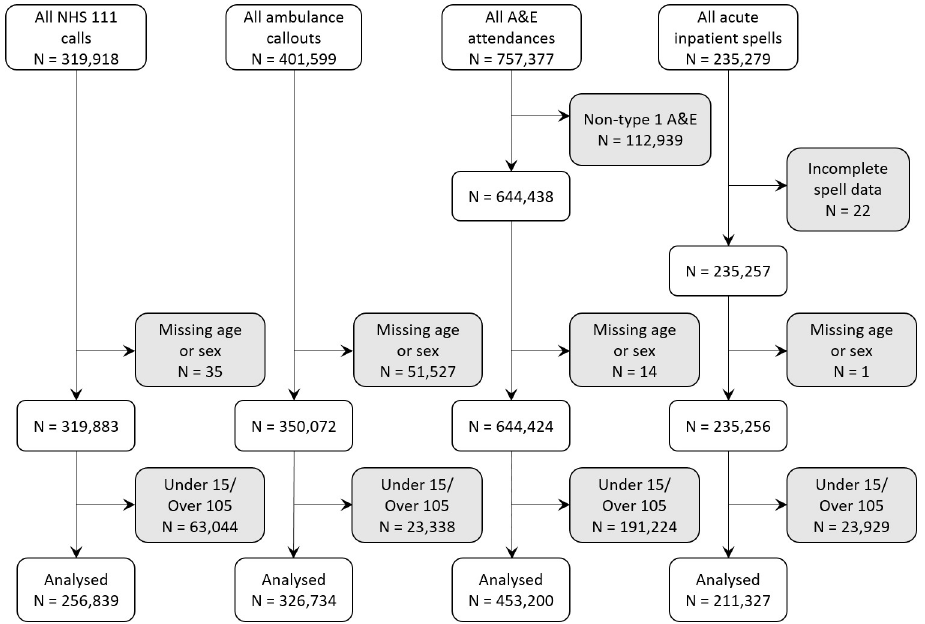
Fig 1. Flow diagram showing exclusions of UEC service records for each